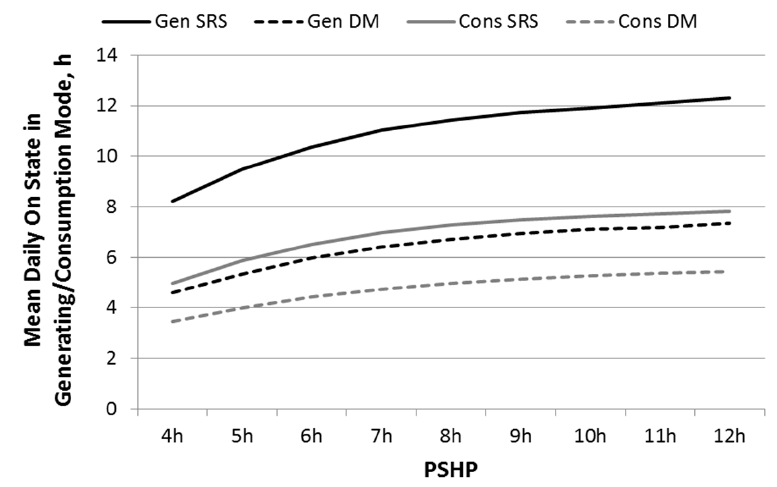
Figure 8. Mean daily hours generating/consuming energy each PSHP participating in the DM and the SRS (black/grey solid lines) and participating only in the DM (black/grey dashed lines).